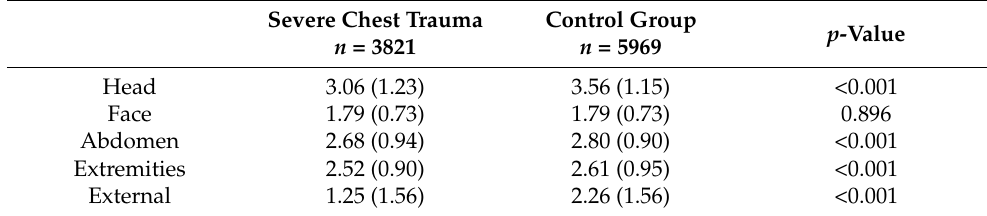
Table 3. Mean values (SD) of the AIS values in the different areas in the severe chest trauma and control groups.